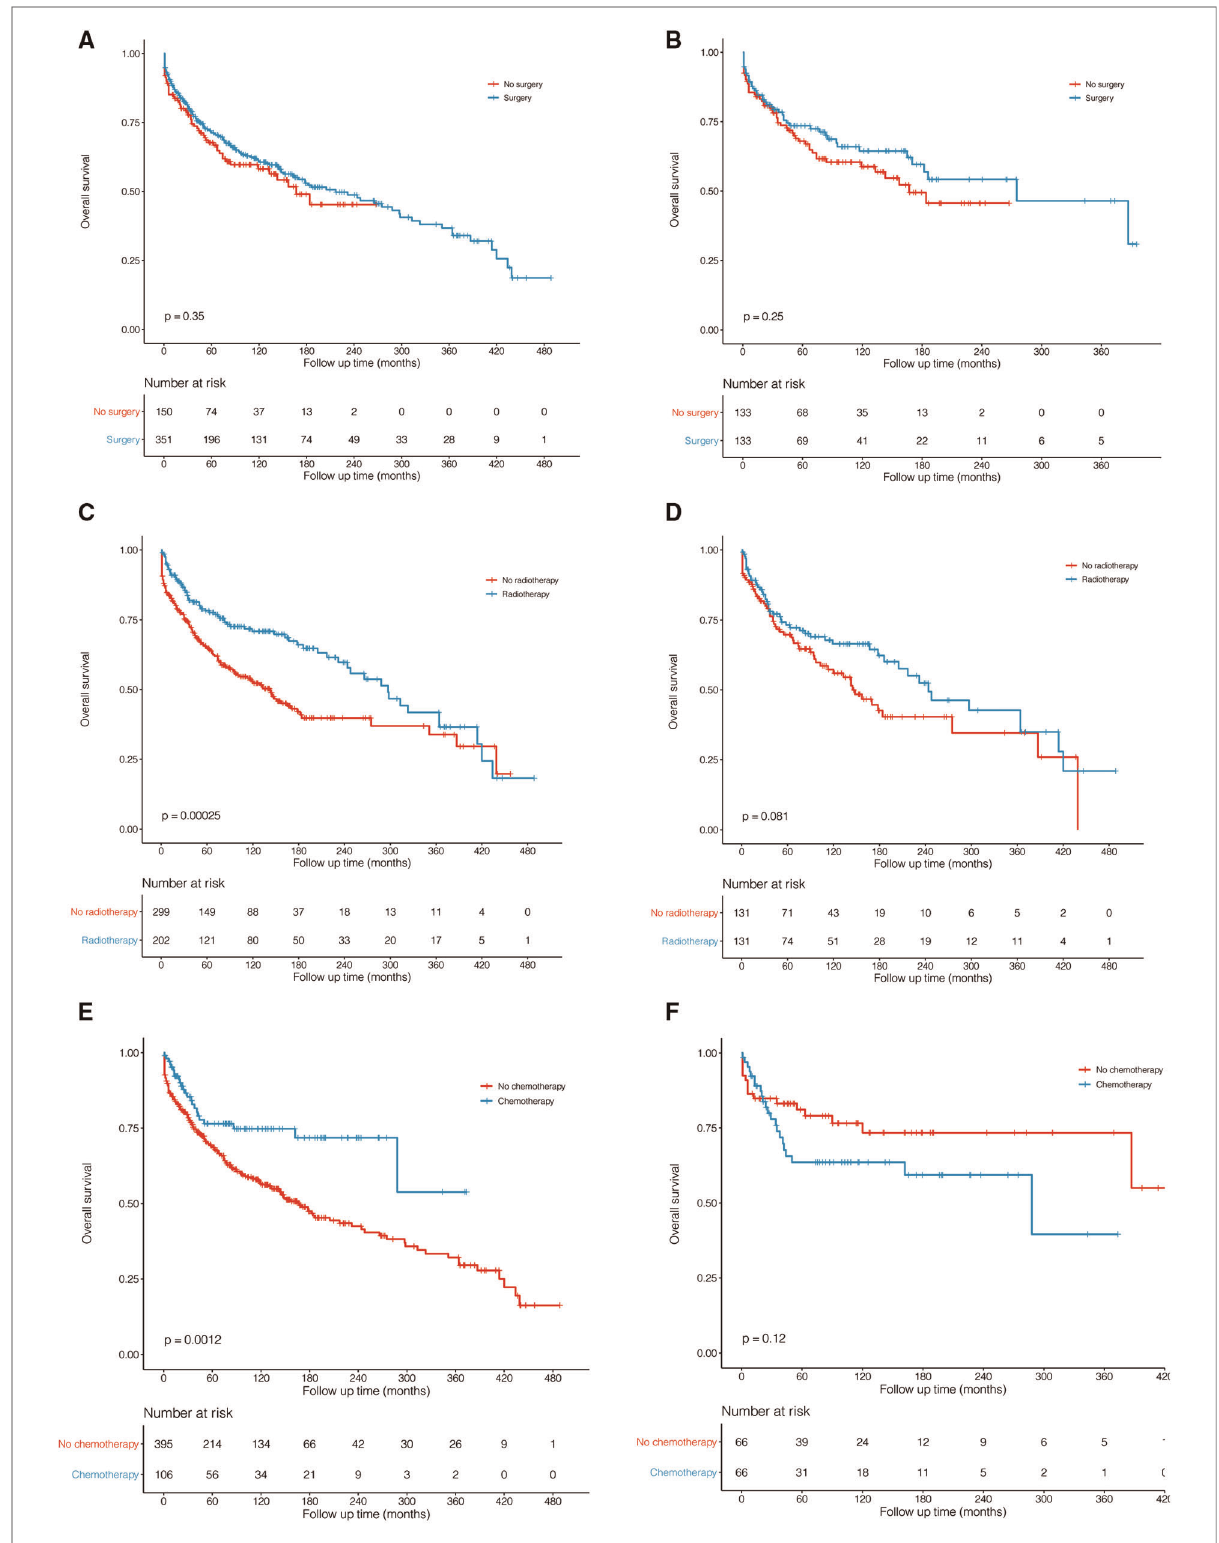
FIGURE 4 Kaplan – Meier survival curves and log-rank tests for treatments before ( A,C,E ) and after ( B,D,F ) propensity score matching (PSM). ( A,B ). Surgery vs. no surgery. ( C,D ) Radiotherapy vs. no radiotherapy. ( E,F ) Chemotherapy vs. no